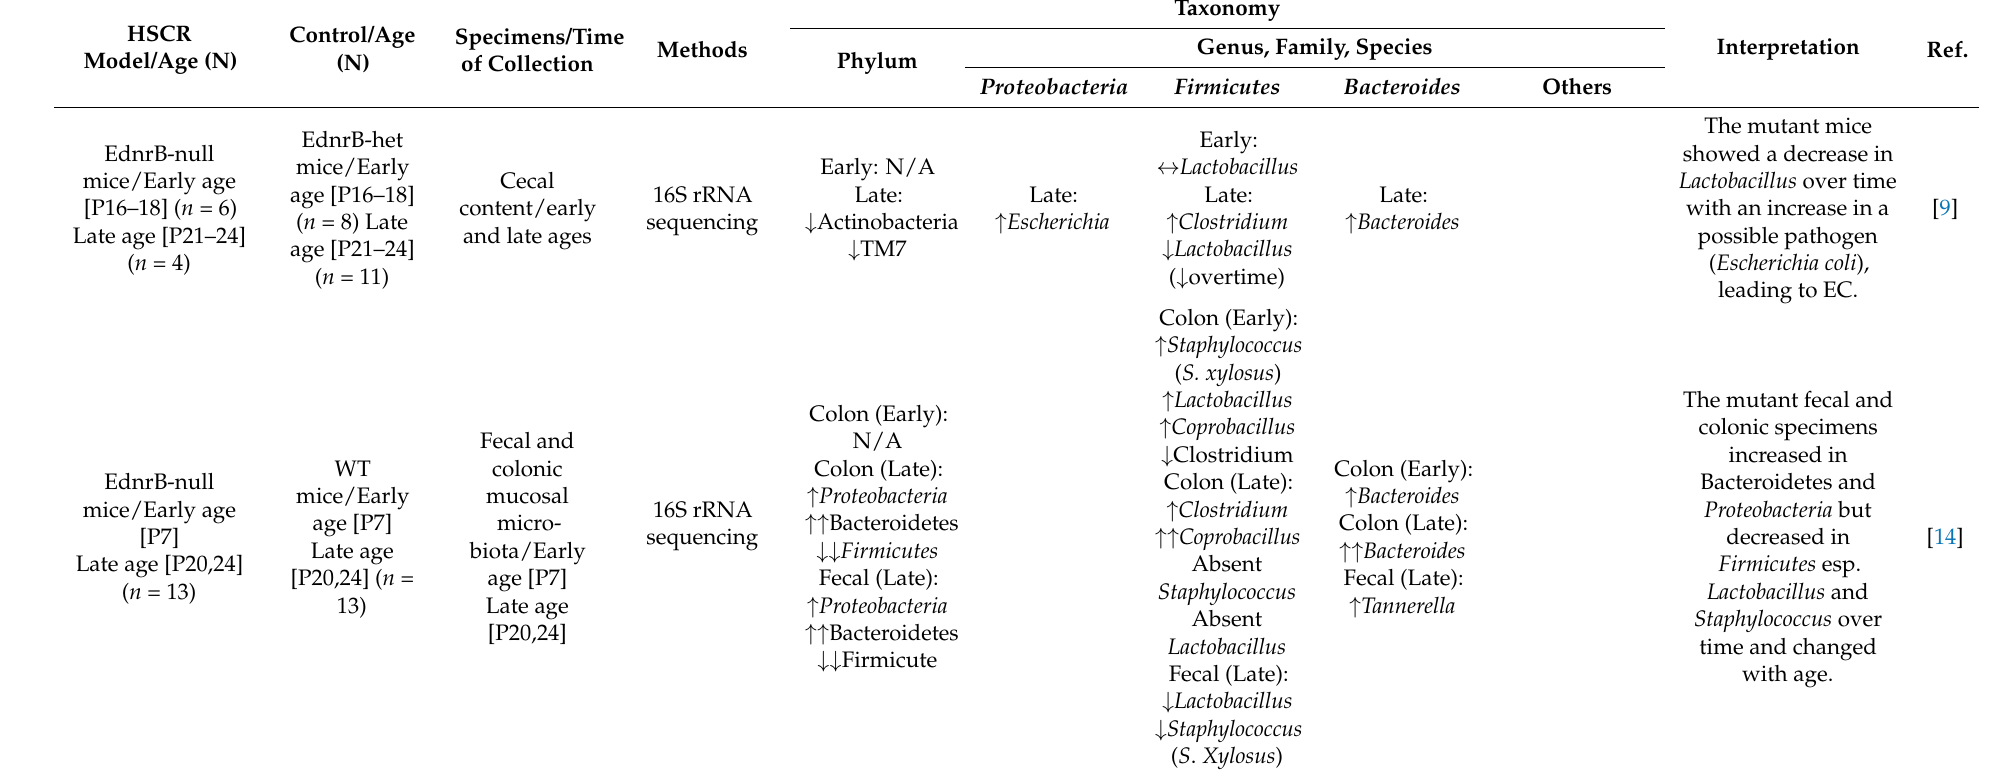
Table 2. The changes of taxa in gut microbiota between subjects with Hirschsprung disease (HSCR) and healthy subjects: Evidence from animal to clinical